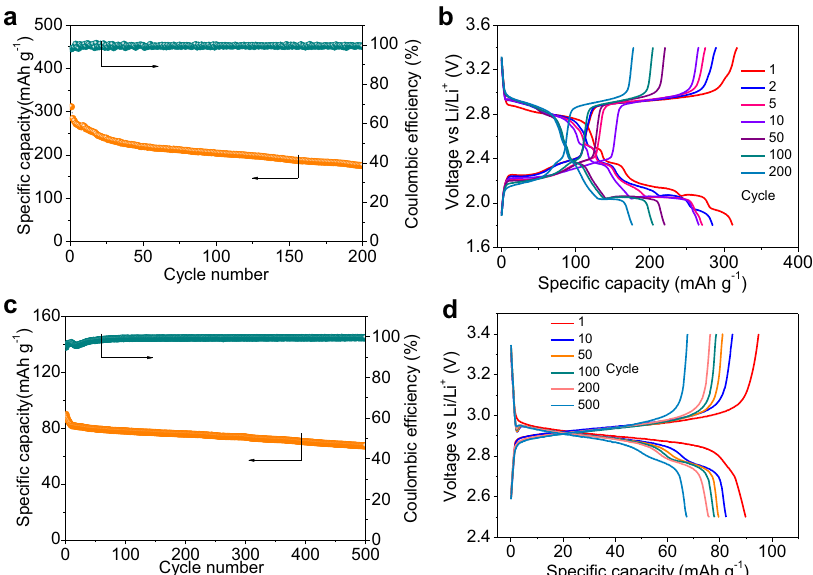
Fig. 6 Cycling performance of the Li/BDPPTS cell. a At C/5 rate with the cut-off voltage between 1.8 and 3.4 V and b selected charge – discharge voltage pro fi les. c At C/5 rate with the cut-off voltage between 2.5 and 3.4 V and d selected charge – discharge voltage pro fi